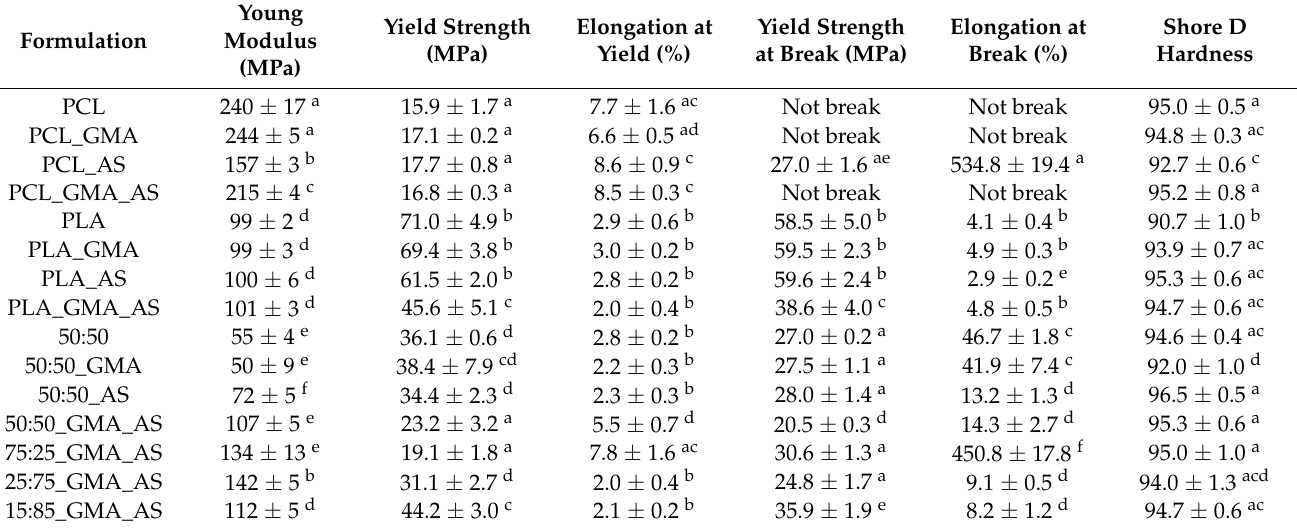
Table 3. Mechanical ( n = 5) and D shore ( n = 3) results obtained for biocomposites. Mean ± SD.